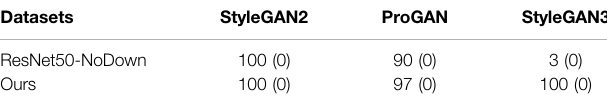
TABLE 5 | Results in terms of Pd@5% (FAR) achieved on spliced images.